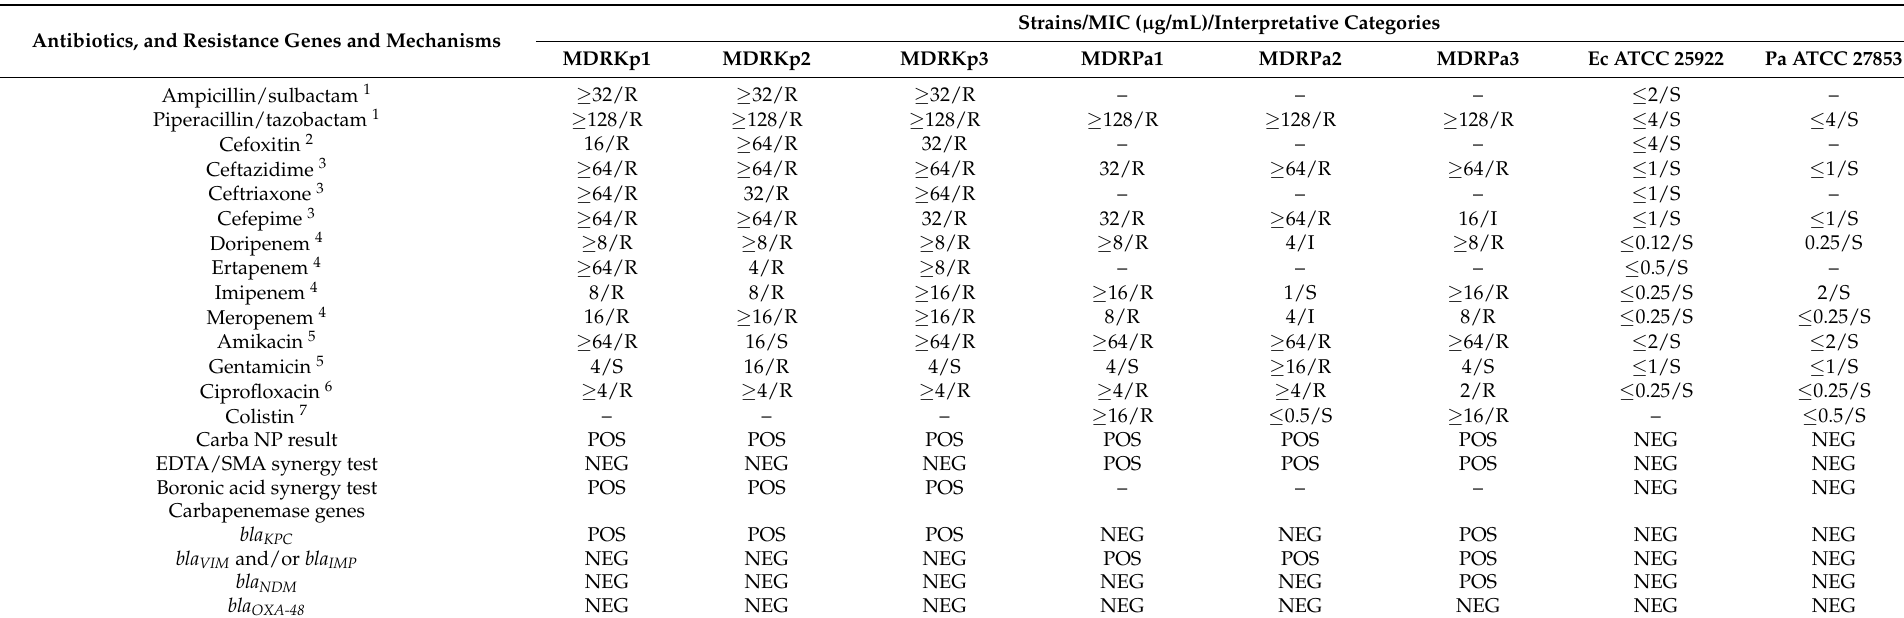
Table 1. Antimicrobial susceptibility and resistance profiles of multidrug-resistant strains of K. pneumoniae and P. aeruginosa . Antibiotics, and Resistance Genes and